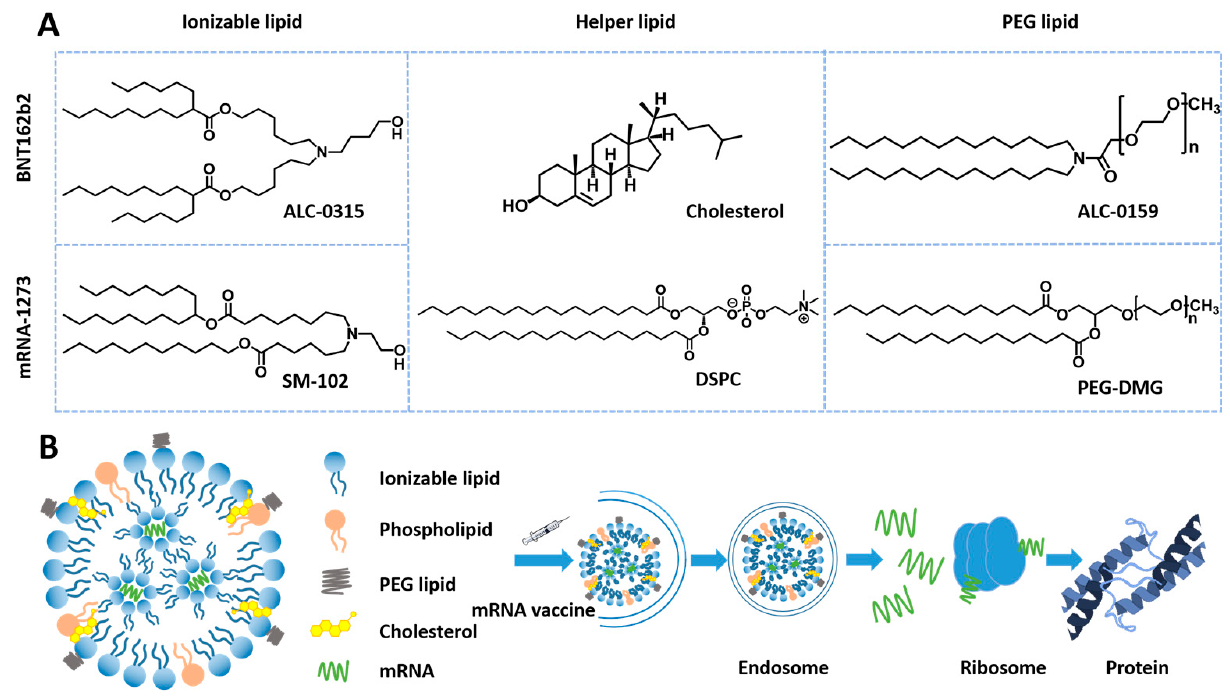
Figure 1. Construction of mRNA-1273 and BNT162b2 and active mechanism. ( A ) Composition and structure of the two mRNA vaccines. ( B ) Active mechanism of mRNA vaccine .